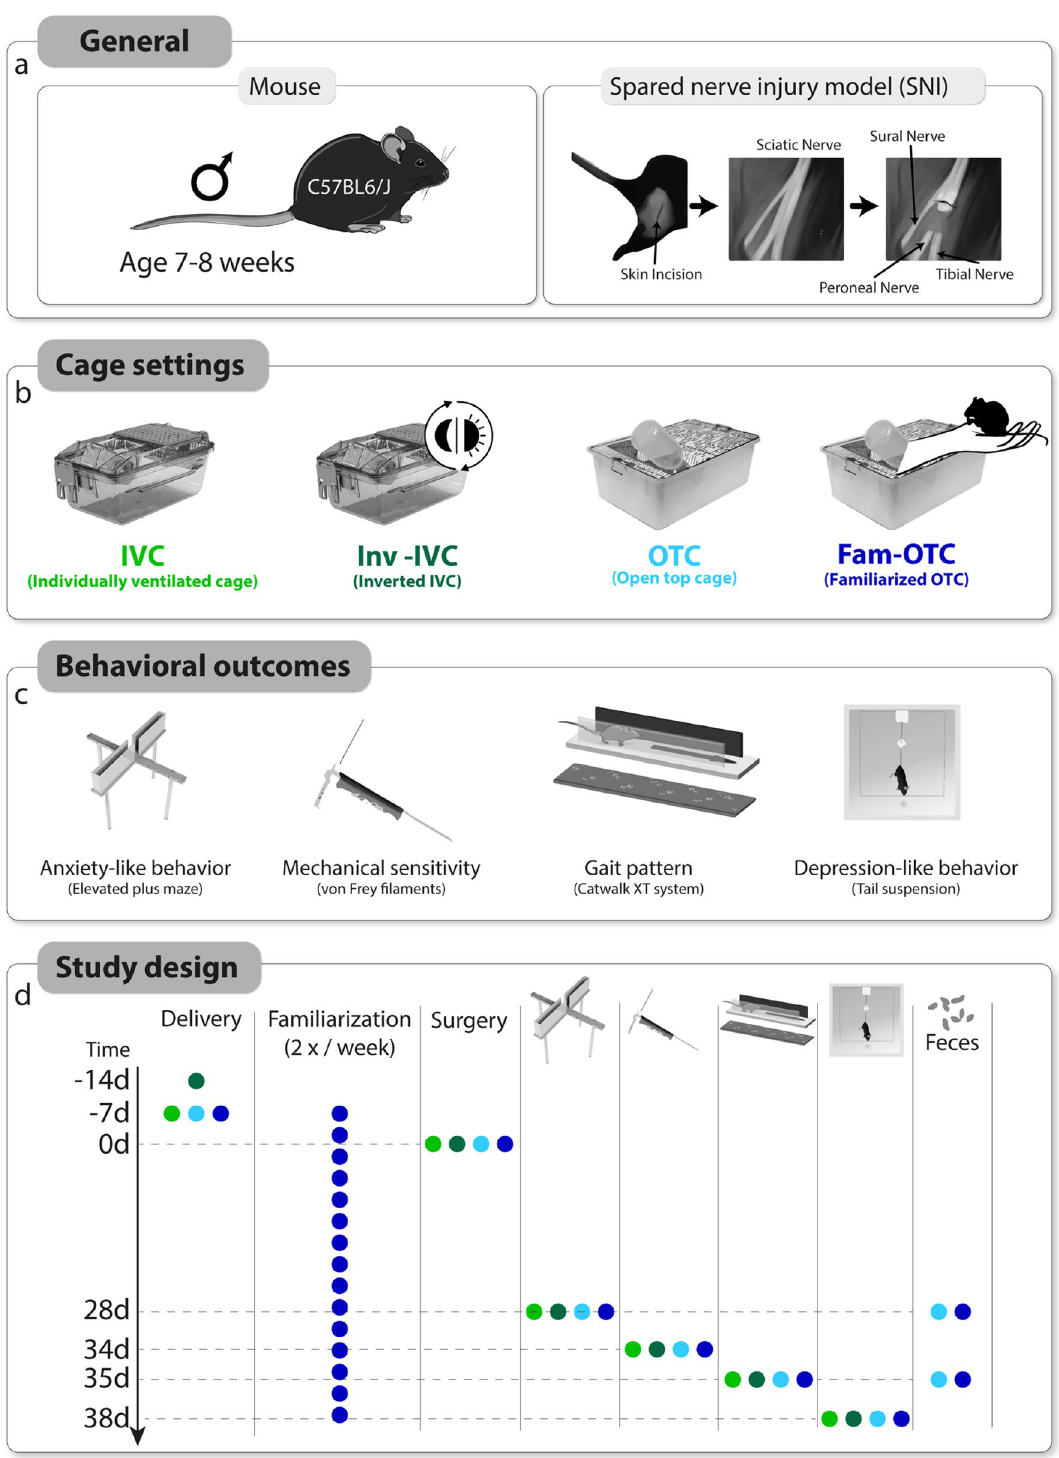
Figure 5. Study characteristics and design. ( a ) Male mice of strain C57/BL6/J and the spared nerve injury (SNI) model to induce peripheral neuropathic pain were used for this study. ( b ) A total of 4 different husbandry conditions were used, which differed in the inverted (Inv) day-night cycle in individually ventilated cages (IVC), the use of open top cages (OTC) without or with experimenter familiarization (Fam-OTC). ( c ) By using pain-, anxiety- and depression-related behavior assessments, distinct phenotypes were characterized, caused by peripheral neuropathy in combination with the four housing conditions. ( d ) An acclimatization phase was followed by induction of SNI and Sham (day (d)0). On d28, testing of anxiety behavior and collection of feces in the OTC and Fam-OTC groups was performed. Mechanical sensitivity testing was performed on d34 and gait assessment on d35 after induction of peripheral neuropathy. After gait testing, feces were collected from the OTC and Fam-OTC groups. Finally, depression-associated behavior was assessed by the tail suspension test